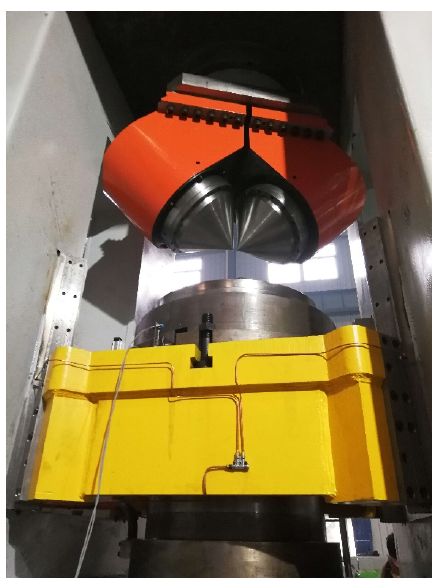
Figure 16. 500t rotary forging press with double symmetry